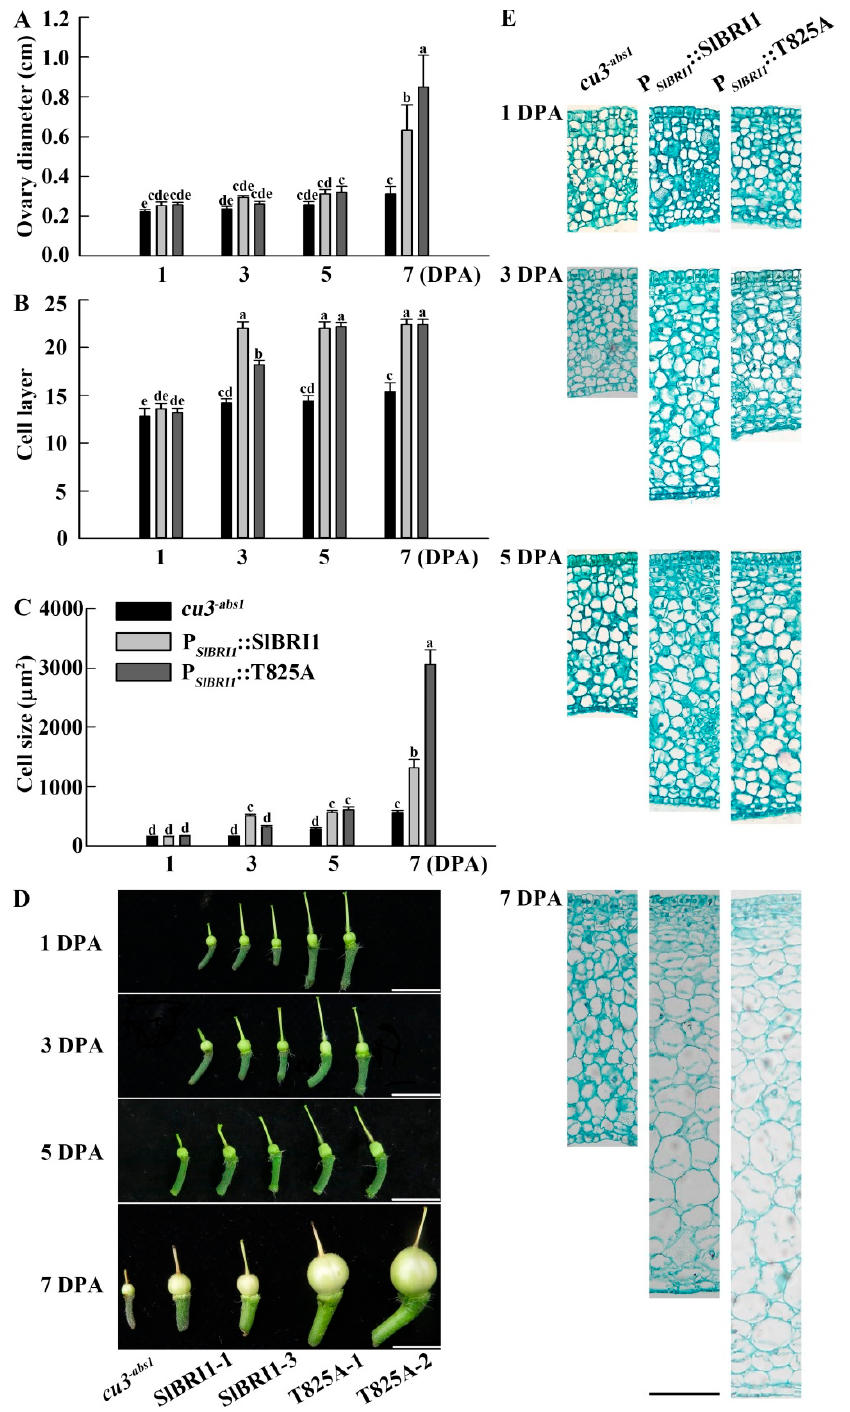
Figure 5. SlBRI1 T825A influences early fruit development. ( A ) Ovary diameters per fruit at 1 DPA, 3 DPA, 5 DPA, and 7 DPA. ( B , C ) The cell layer ( B ) and cell size ( C ) of equatorial sections of the ovary walls per fruit at 1 DPA, 3 DPA, 5 DPA, and 7 DPA. ( D ) Phenotypes of ovary per fruit at 1 DPA, 3 DPA, 5 DPA, and 7 DPA. Scale bars represent 1 cm. ( E ) Phenotypes of the equatorial sections of the ovary walls per fruit at 1 DPA, 3 DPA, 5 DPA, and 7 DPA. Scale bar represents 100 μ m. The data for ( A ) are presented as the mean ± SD ( n = 15). The data for ( B , C ) are presented as the mean ± SD ( n = 5). The different letters indicate significant differences (one-way ANOVA, Tukey’s test, p < 0.05).